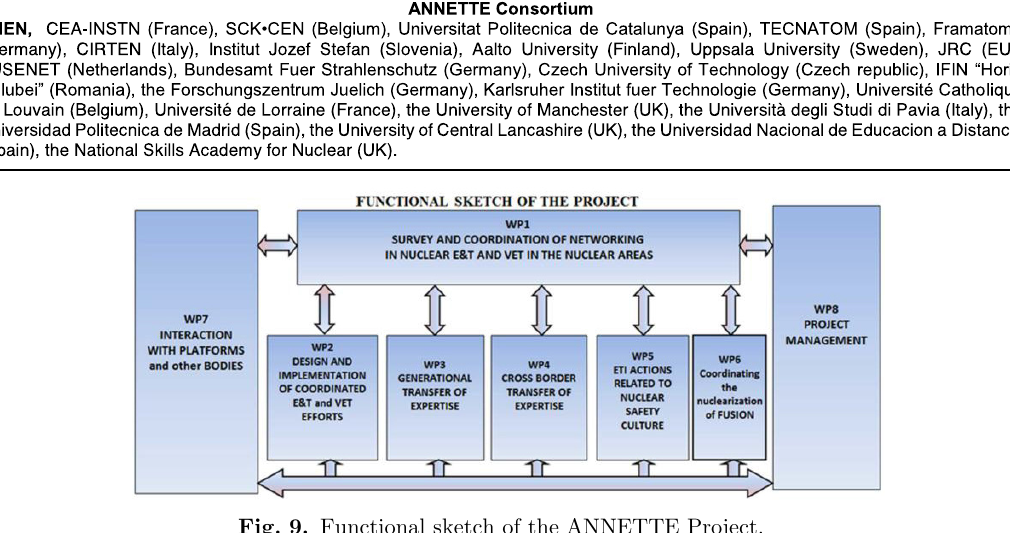
Fig. 9. Functional sketch of the ANNETTE